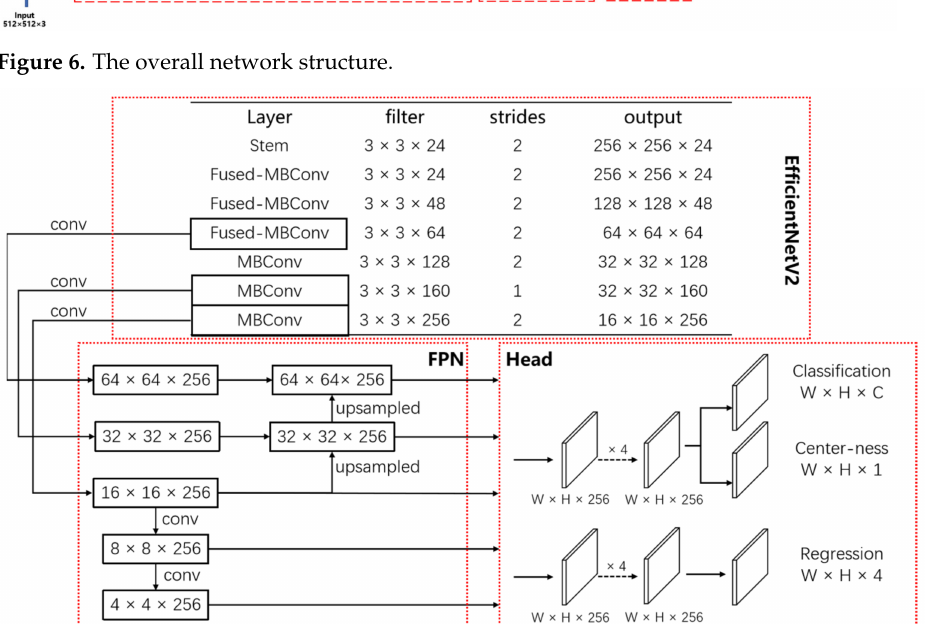
Figure 7. Specific parameters and processes of the